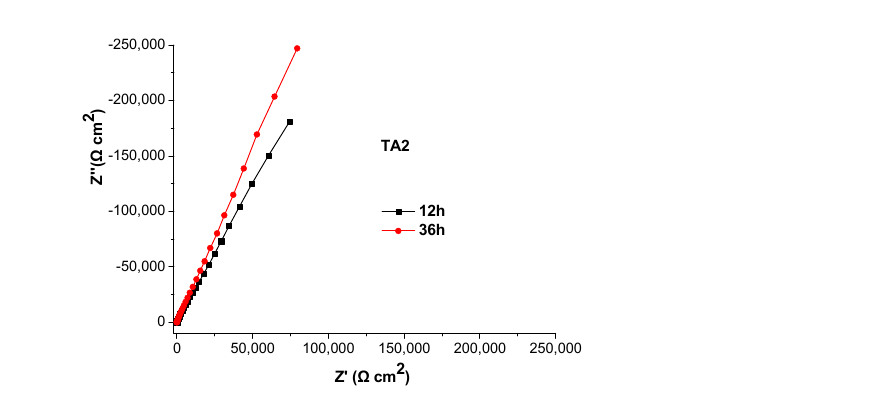
Figure 9. Nyquist plots of EIS of MAO-1, MAO-2 and bare TA2 specimens measured after immersion in 3.5% NaCl solution for 12 and 36 h, respectively.